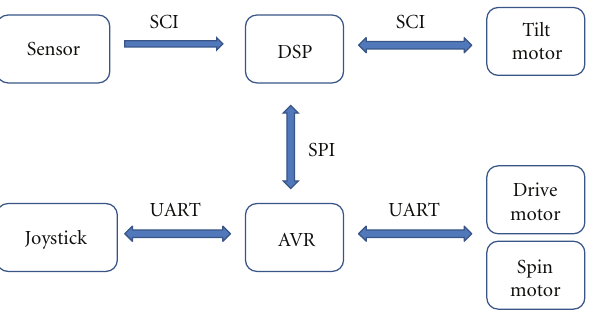
Figure 13: Control hardware block